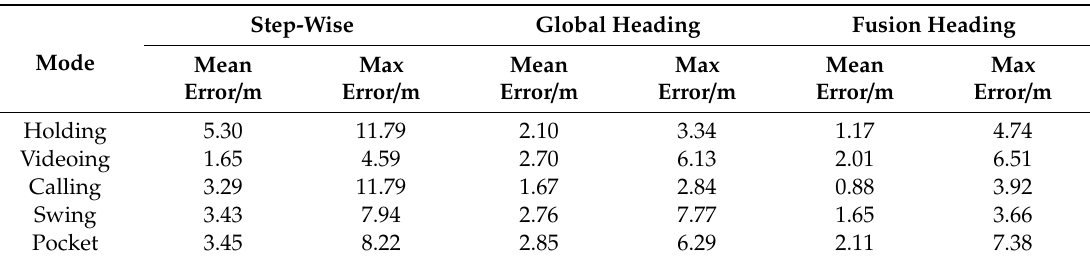
Table 5. Mean and maximum comparison of the position errors for di ff erent heading estimation methods in five